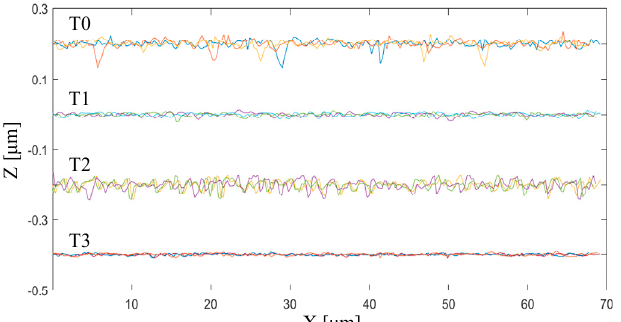
Figure 16. Machined surface topographies along the cutting paths extracted from Figure 15 by different tool-edge qualities (T0, T1, T2, and T3).